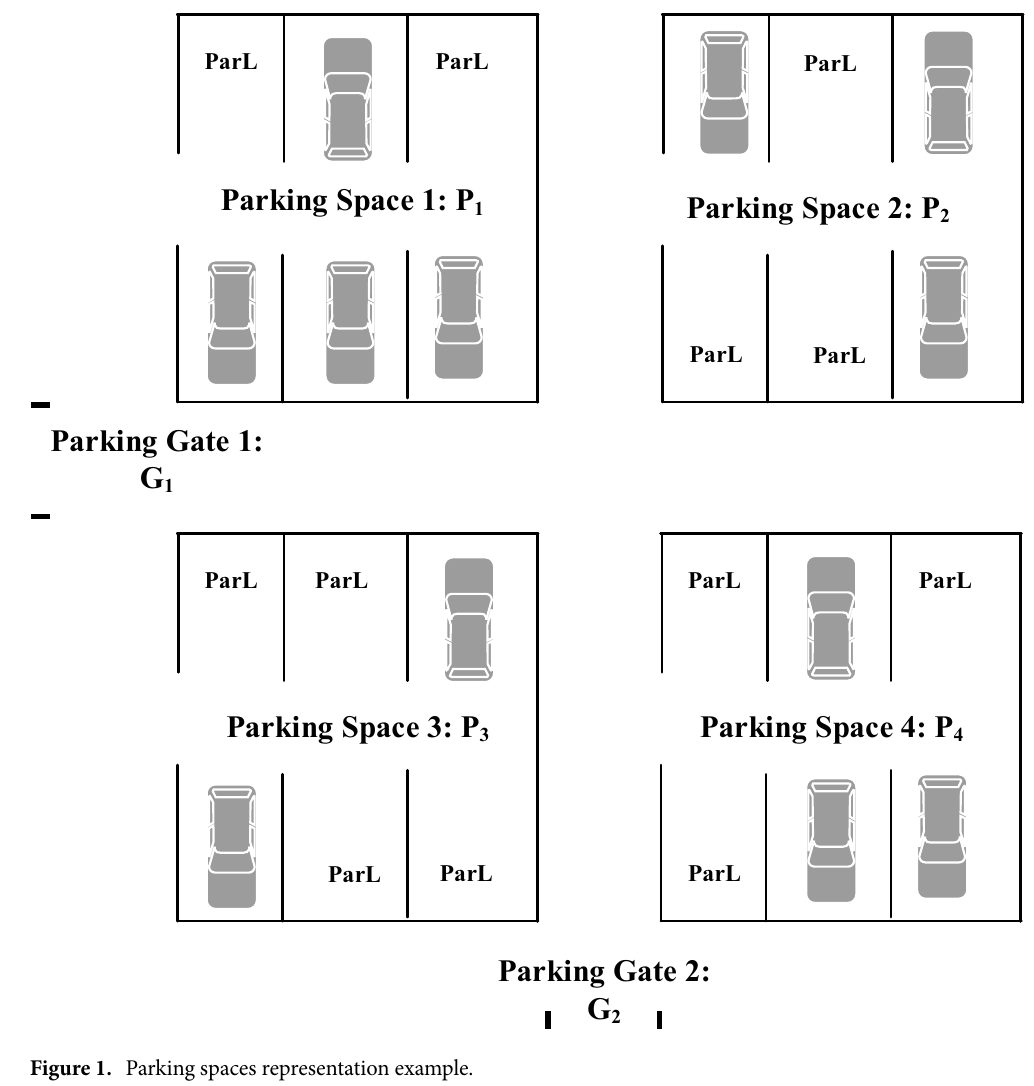
Figure 1. Parking spaces representation